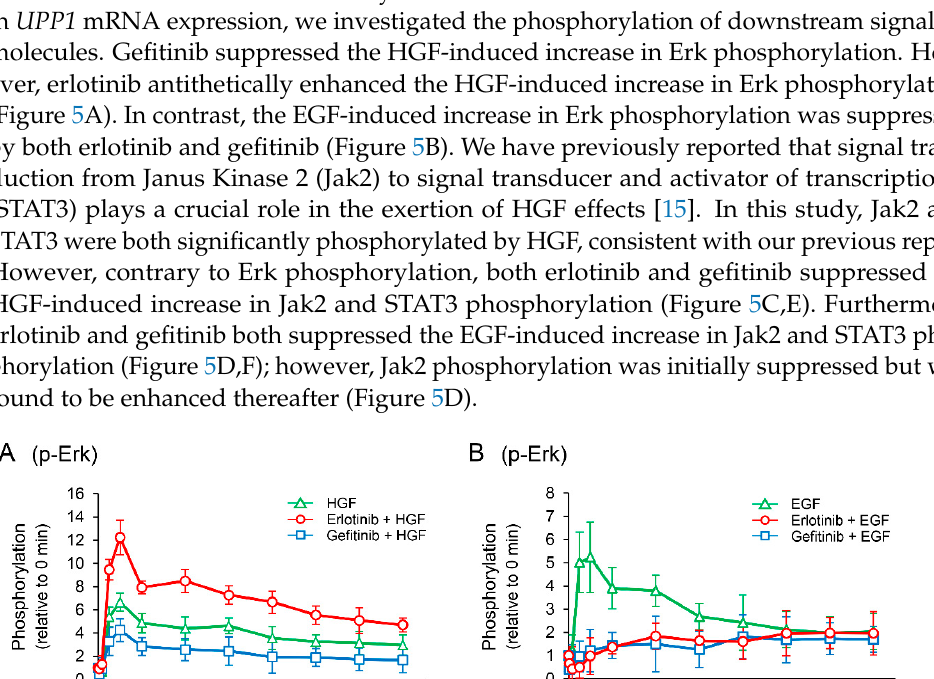
Figure 5. Effects of erlotinib and gefitinib on growth factor-induced phosphorylation of downstream signaling molecules. HepG2 cells were cultured for 24 h in serum-starved medium. Thereafter, HGF (50 ng/mL) or EGF (50 ng/mL) was added to the medium. Cells were pretreated with erlotinib (5 µM) or gefitinib (1 µM) 15 min before treatment with growth factors. Total protein was collected at